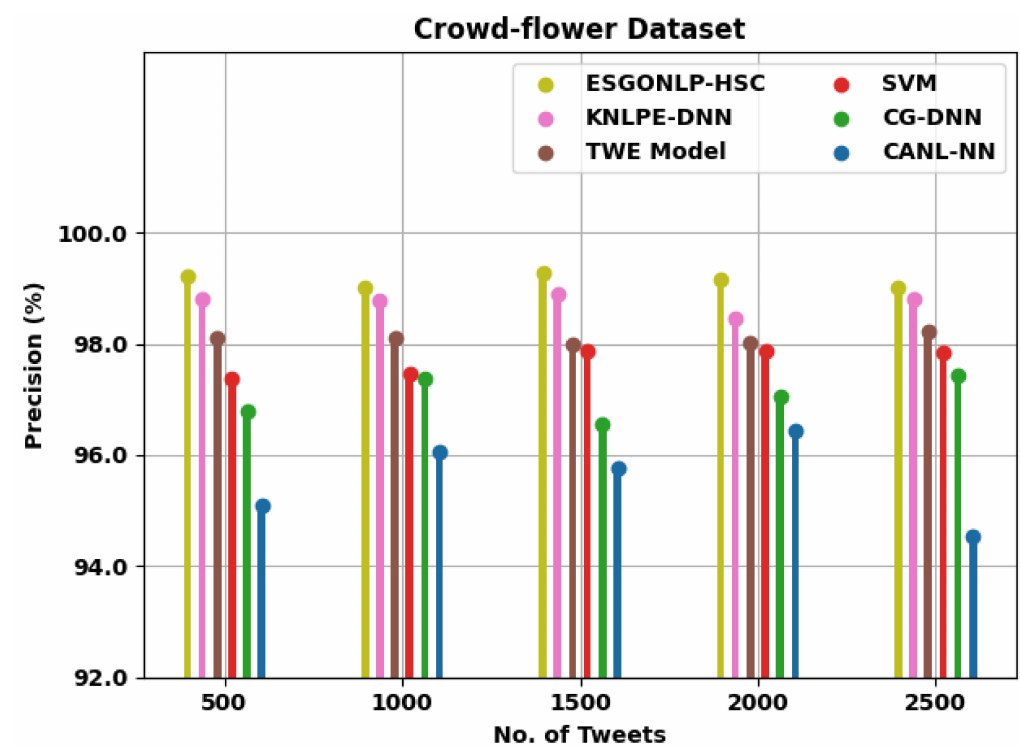
Figure 6. Prec n analysis of ESGONLP-HSC technique under Crowd-flower dataset. Table 4. Recall analysis of ESGONLP-HSC method with existing approach under Storm front and Crowd-flower datasets.